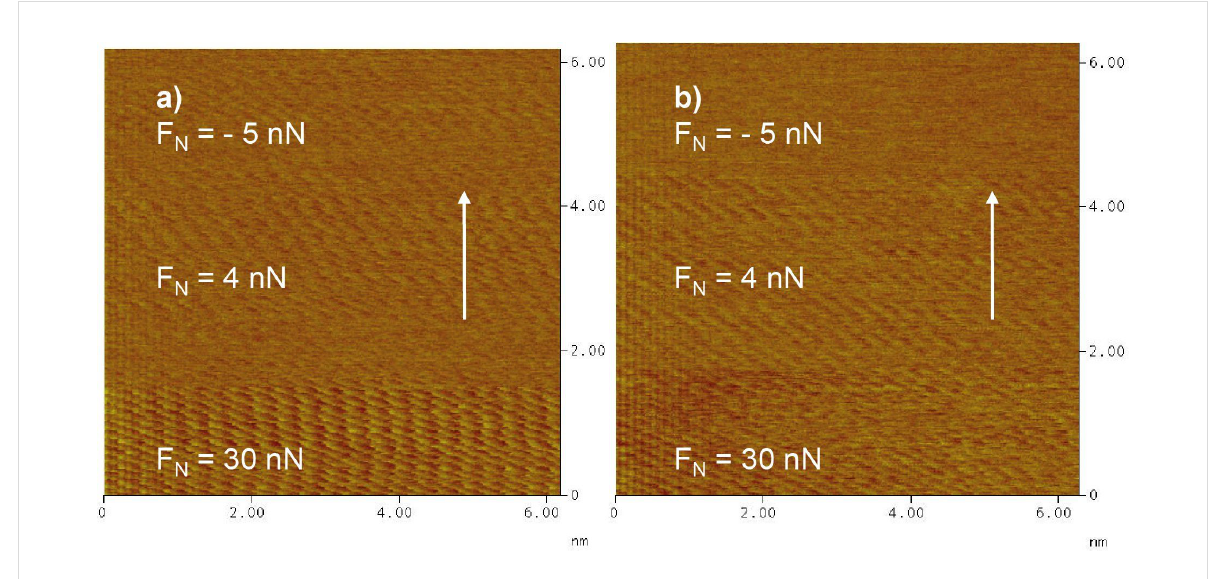
Figure 12: Friction images on Au(111). a) atomic resolution on Au(111) (no transition to non-stick–slip at this potential); F N = − 5, 4, 30 nN; E = 250 mV; scan rate 154 nm/s. (In this image, the apparent gradual change of the lattice direction at the beginning of the upward scan – lower part of the image – is an artefact probably due to the hysteresis of the scanner piezo.) b) Transition from non- to regular stick–slip behaviour at F N = 4 nN; E = 420 mV; scan rate 154 nm/s.